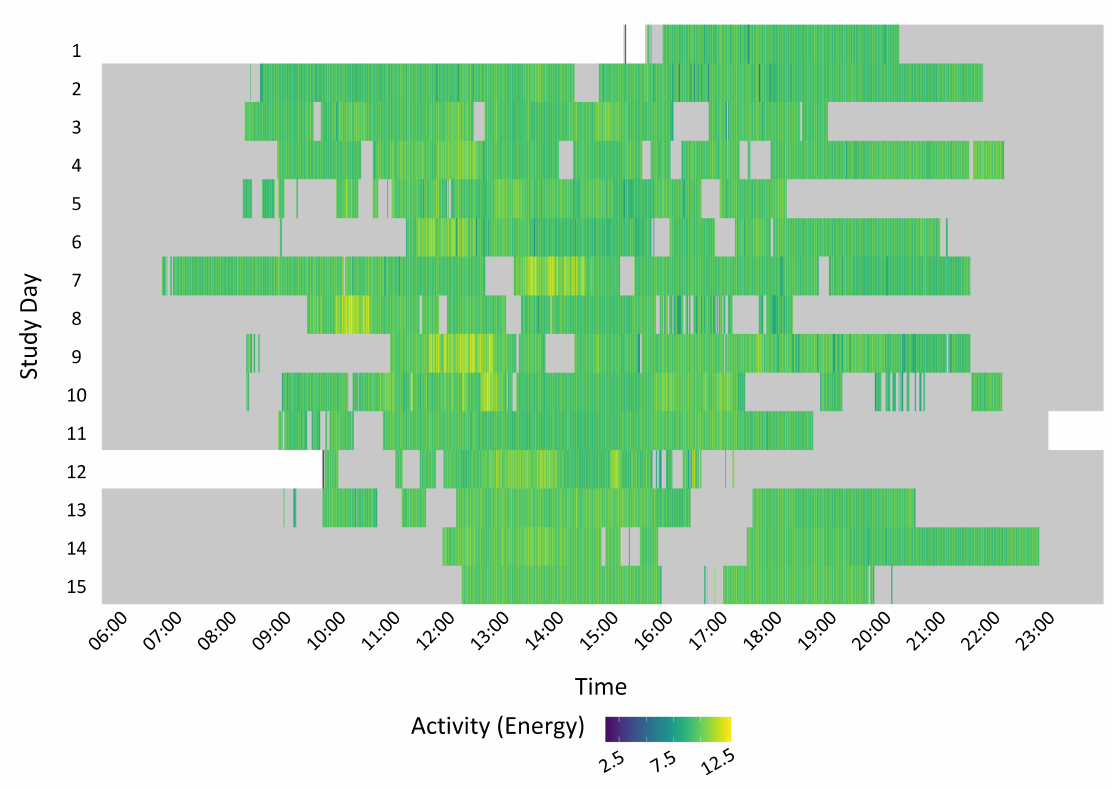
Figure 10. Actigram of patient 232; rows present days; activity is aggregated as variance of the acceleration signal over one-minute windows; grey represents off-body data, white shows gaps of data.